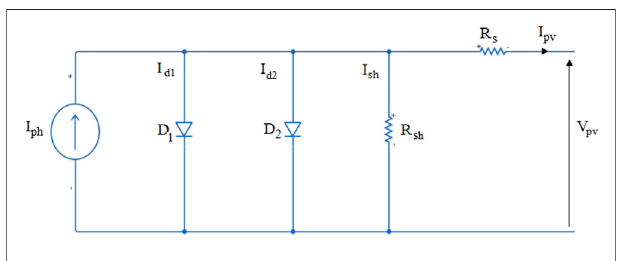
FIGURE 5 | Double diode equivalent circuit (Bakhoda et al.,